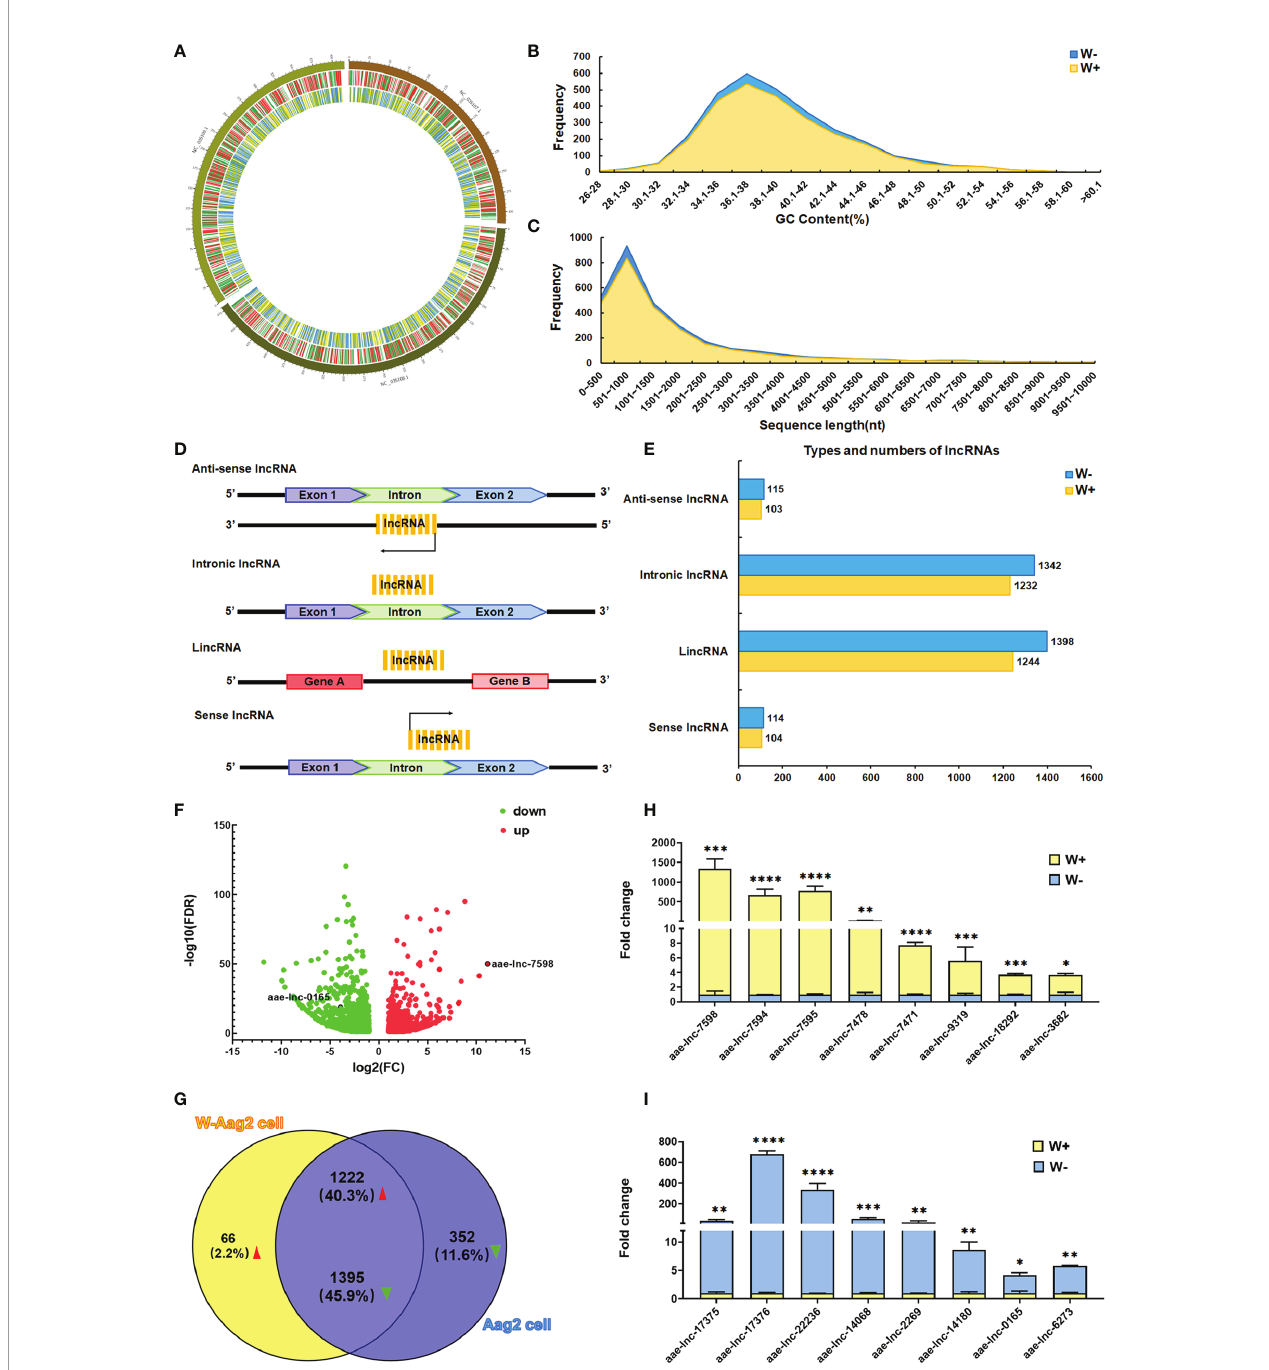
FIGURE 1 | Wolbachia w AlbB induces differential expression of lncRNA in A. aegypti . (A) Distribution of differentially expressed (DE) lncRNAs and mRNAs on a chromosome map. The outer circle shows the chromosome map of A. aegypti , the middle circle indicates the distribution of DE mRNAs on the chromosomes of A. aegypti , and the inner circle shows the distribution of DE lncRNAs on the chromosomes of A. aegypti . The red and green lines in the circle represent upregulated genes and downregulated genes, respectively. Yellow and blue lines represent up-regulated lncRNAs and down-regulated lncRNAs, respectively. (B) The GC content of DE lncRNAs identi fi ed in A. aegypti . (C) The length distribution of identi fi ed DE lncRNAs. (D) Schematic diagram of the origin and type of lncRNAs. (E) Types and numbers of DE lncRNAs; the lncRNAs are classi fi ed into four types. For each type of lncRNA, the number of lncRNAs per cell line are presented in different colors. (F) Volcano maps of 3035 DE lncRNAs; the red dots indicate upregulated lncRNAs, green dots indicate downregulated lncRNAs. (G) Venn diagram of the 3035 DE lncRNAs in A. aegypti . qPCR validation of signi fi cantly down-regulated lncRNAs (H) and up-regulated lncRNAs (I) in lncRNA sequencing; **** P < 0.0001; *** P < 0.001; ** P < 0.01, * P <